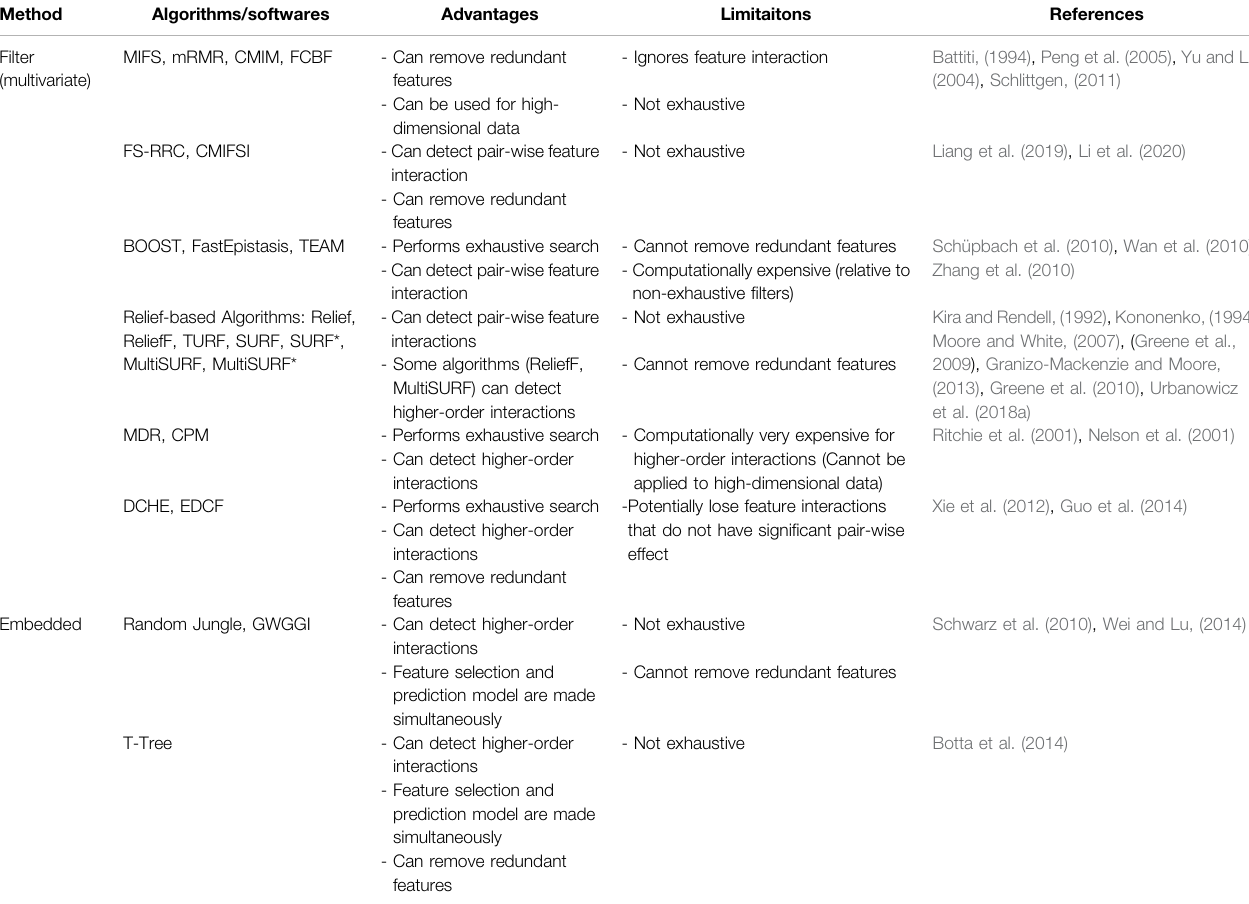
TABLE 3 | Advantages, limitations, and references for the feature selection algorithms reviewed in this